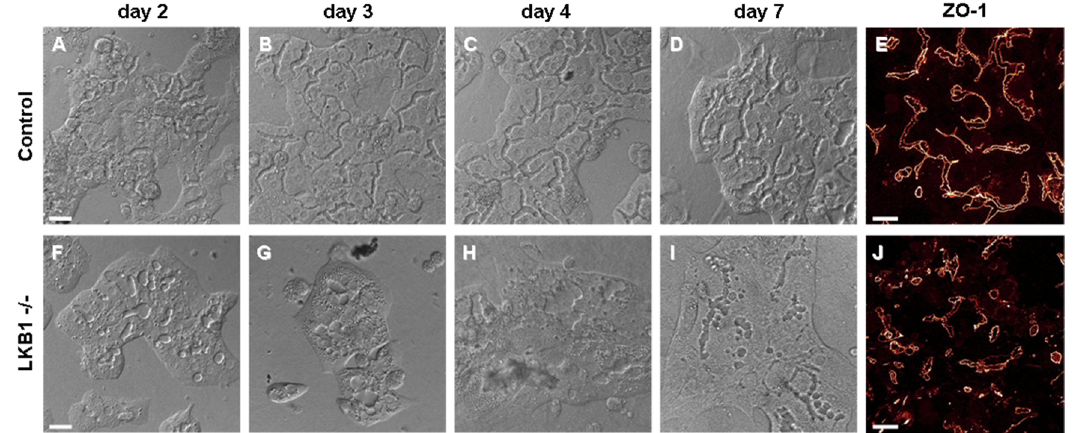
Figure 1. Canalicular structure formation in control and LKB1 2 / 2 mouse hepatocytes. Progression of canalicular network formation was monitored in collagen sandwich cultures of mouse hepatocyte by DIC imaging. Elapsed times after cell isolation and seeding are indicated on the top. ( A–D ) In control cells, interconnecting canaliculi were gradually developed within 3–4 days. ( E ) Immunostaining of ZO-1 protein on day 6 suggests that canalicular structures are firmly sealed with tight junctions in these hepatocyte cultures (also see Video S1). ( F–I ) In contrast to control cells, LKB1 2 / 2 hepatocytes developed only short and isolated canalicular structures. No interconnecting canaliculi were observed even 7 days after plating. ( J ) Similar result is obtained by anti-ZO-1 immunostaining performed on day 6. Note that despite the irregular morphology, tight junction proteins were present in the canaliculi of LKB1 2 / 2 cells. Maximal projection of confocal images is shown. Scale bars 25 m m.